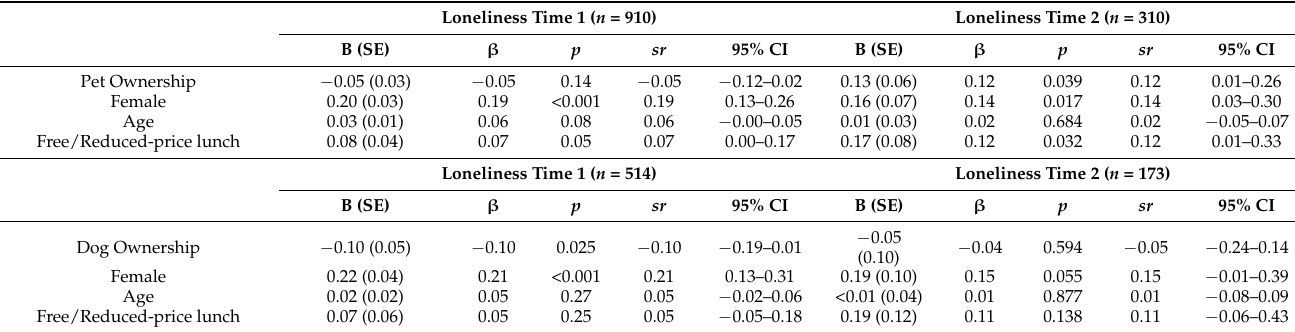
Table 1. Pet ownership and dog ownership predicting loneliness at Time 1 (pre-COVID) and Time 2 (during COVID), controlling for gender, age, and free/reduced price lunch status.